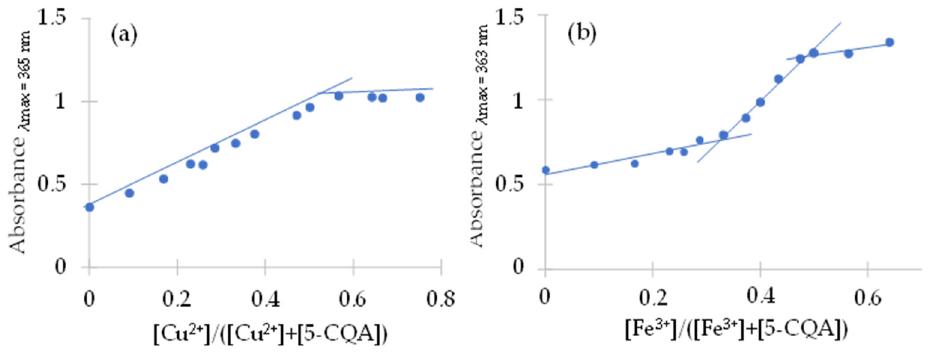
Figure 7. The mole-ratio plot for the estimation of the composition of ( a ) Cu(II) and ( b ) Fe(III) chlorogenate complexes.